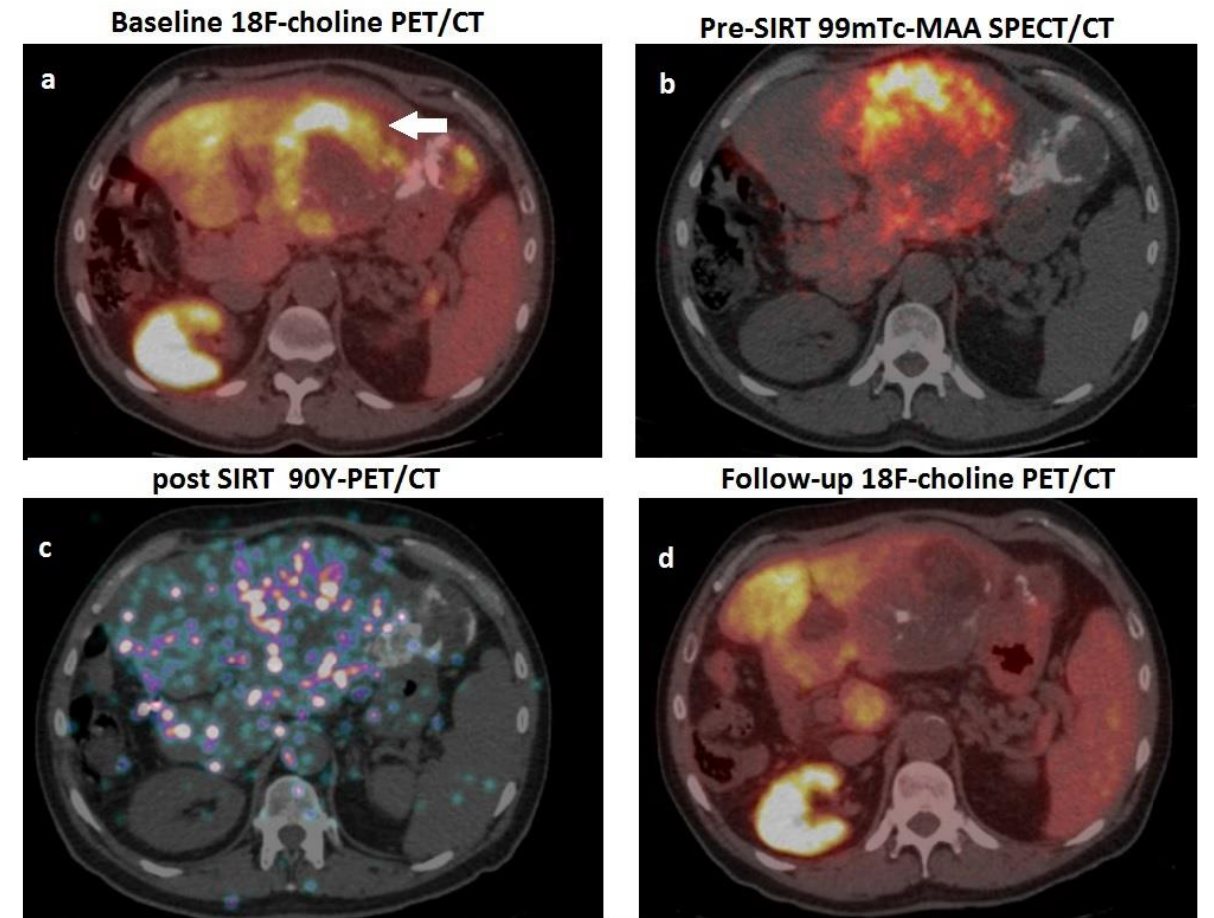
Figure 4. A 62-year-old man, affected by HCV-related cirrhosis, presenting a gross HCC of the left hepatic lobe, previously submitted to surgery (moderately differentiated HCC, pT2), subsequently relapsed and was treated with TACE. One year after TACE, he was referred to our department due to relapse and increased value of AFP (2357 ng/mL) for possible treatment with 90 Y-microspheres. ( a ) Pre-treatment PET/CT scan with 18F-choline showed a hemicircular rim of increased tracer uptake (white arrow) within the HCC lesion in the left hepatic lobe (note the hyperdense material in the neighbouring parenchyma due to the previously performed TACE). ( b ) The patient was submitted to scintigraphy with albumin 99mTc-macroaggregates (i.e., PRE-SIRT), and coregistered SPECT-CT images showed an optimal match with respect to the location of the metabolically active lesion detected by PET/CT; ( c ) After selective catheterisation of the arterial feeder of the HCC lesion, 1.8 Gbq of 90Y-resin microspheres were administered; PET/CT acquired on 90Y-positron emission showed microspheres’ accumulation within the hepatic lesions; ( d ) 18F-choline PET/CT performed eight weeks after SIRT showed an almost complete metabolic response, consistent with a dramatic drop in AFP values (i.e., 50 ng/mL).